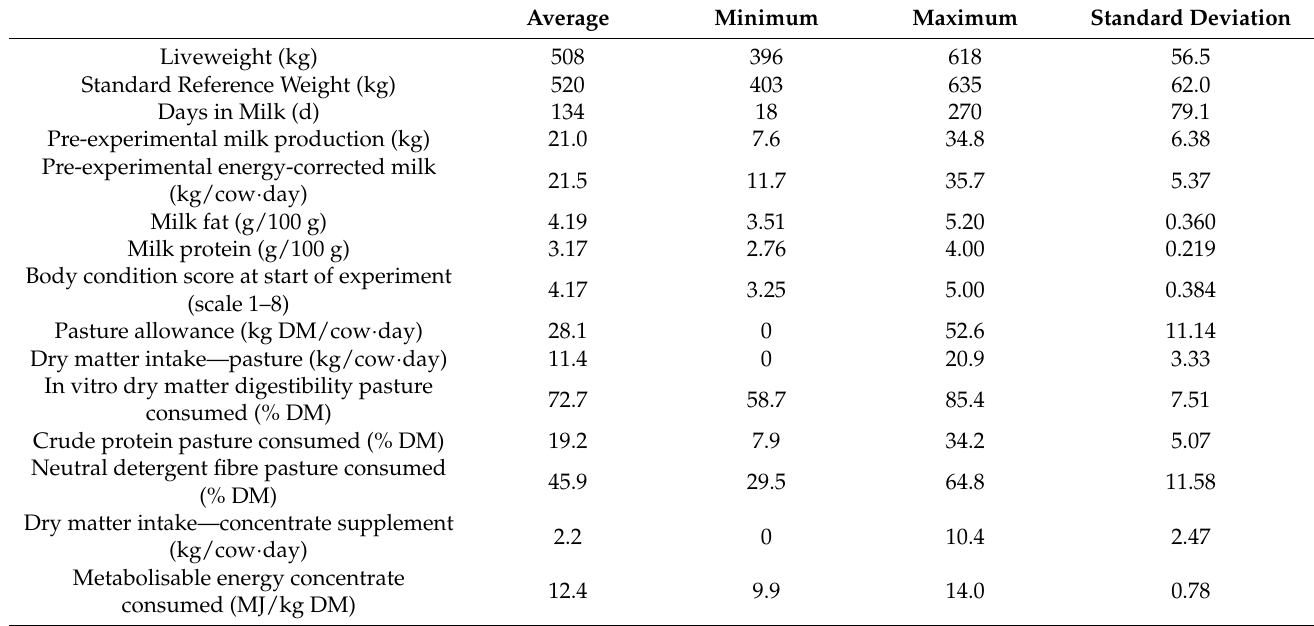
Table 4. Average, minimum, maximum and standard deviation of key animal, pasture and supplementary feed descriptors included in the